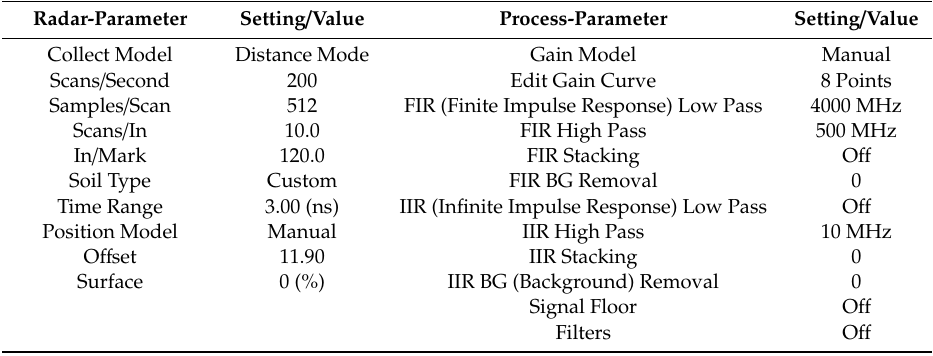
Table 3. Control Parameter settings used on Subsurface Interface Radar (SIR)-4000